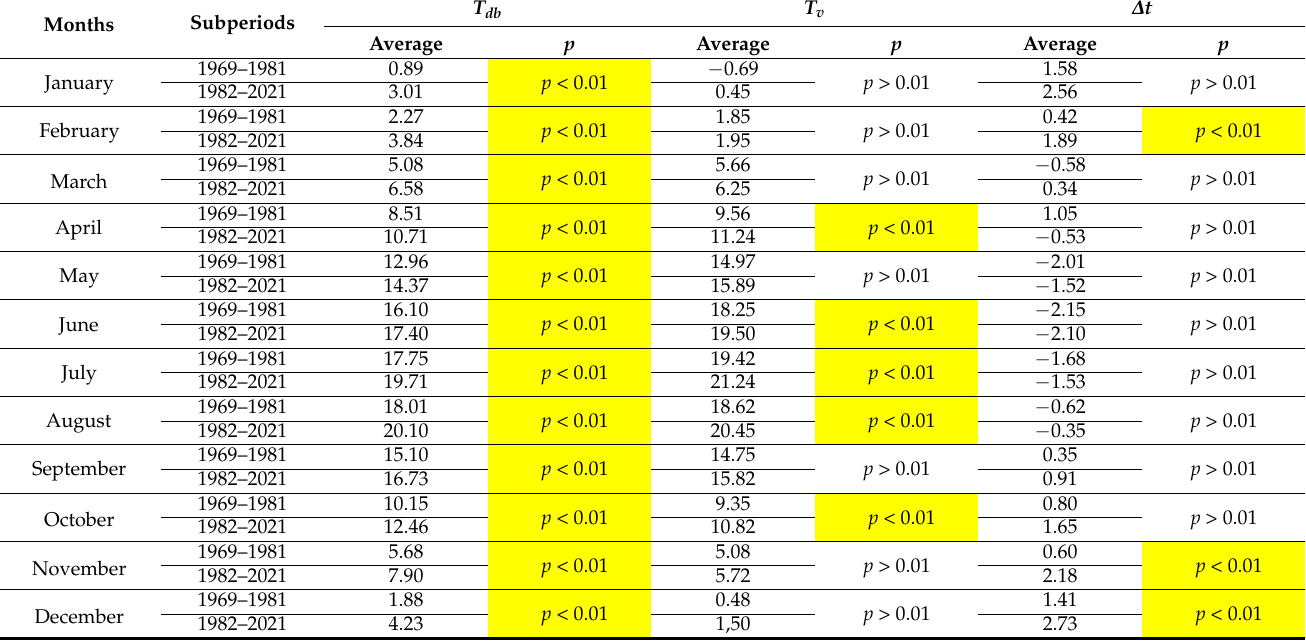
Table 6. Average values of the subseries of monthly water temperatures of the Drava near Botovo (1969–1981 and 1982–2021), T DB , the subseries of Varaždin air temperature, T V , and the subseries of their differences, Δ T = T DB − T V , and the probability of the t -test, p.